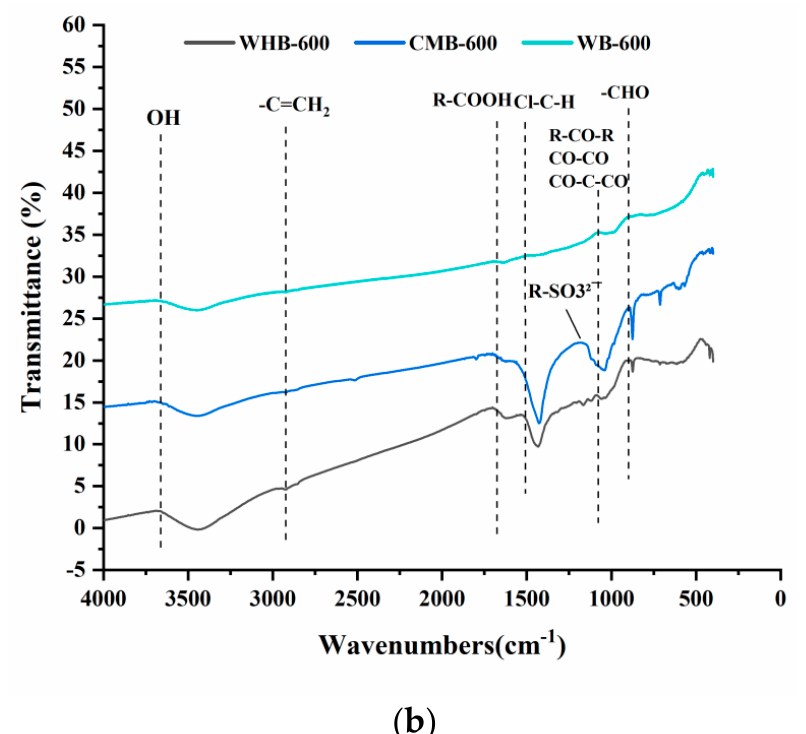
Figure 4. ( a ) FTIR spectrum of biochar prepared at 300 °C. ( b ) FTIR spectrum of biochar prepared at 600 °C.